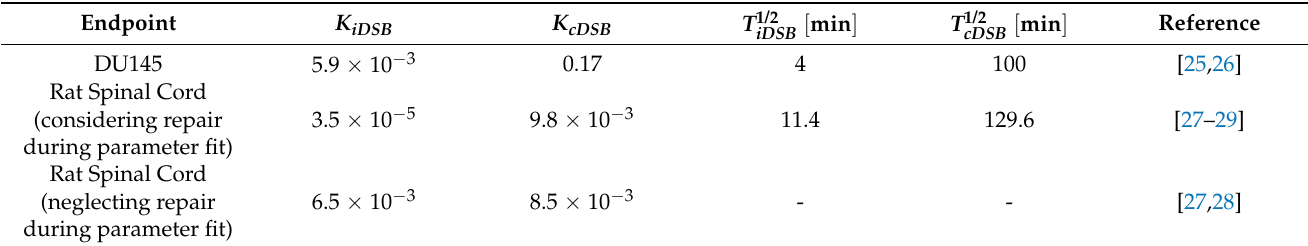
Figure 2. Proton RBE predictions for the DU145 cell-line over the applied dose rate for the fixed- reference RBE (2 Gy/min; green dashed line) as well as the dose-rate adapted RBE (dotted orange line) by using the extended version of the UNIVERSE for three representative LET values at higher doses. The no-repair RBE is shown for reference (solid blue line). Table 1. Endpoint dependent UNIVERSE parameters applied in this work.